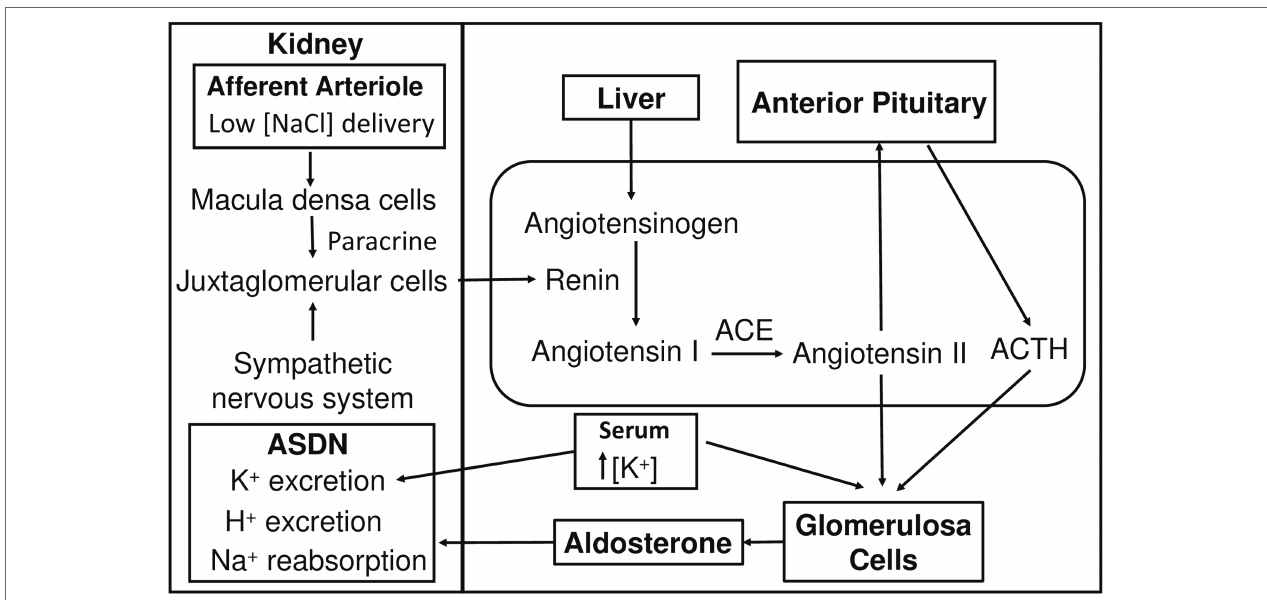
FIGURE 1 | Hypotension-induced activation of the renin-angiotensin-aldosterone system. As blood pressure drops, juxtaglomerular cells receive signals from macula densa cells and the sympathetic nervous system and secrete renin into the circulation. Renin hydrolyzes liver-synthesized angiotensinogen into inactive